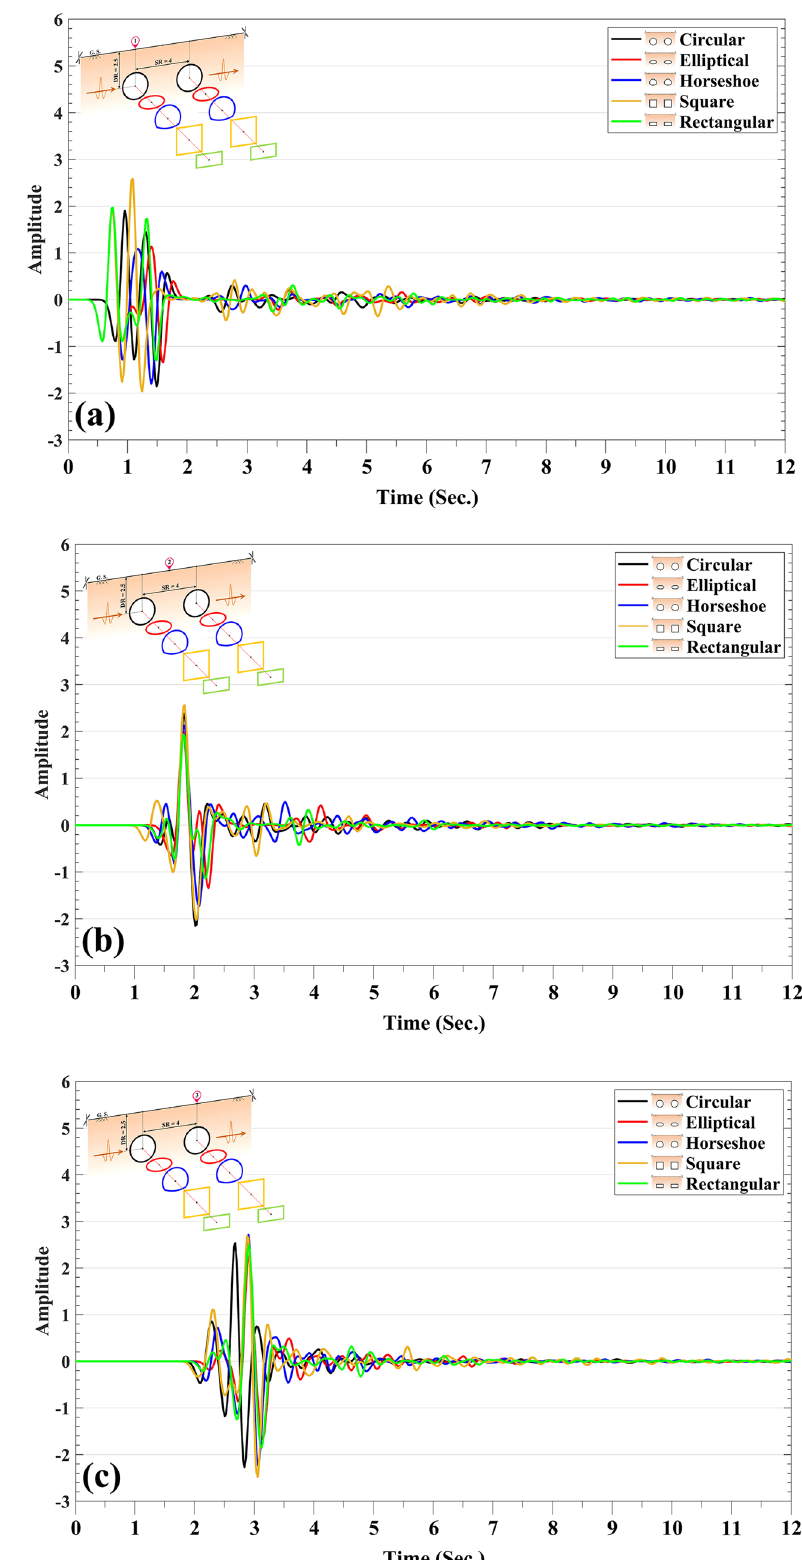
Fig. 4 The amplitude of propa- gated waves on the surface versus time, for the model of twin lined tunnels with differ- ent geometries in a centerline of the first tunnel, b central point, c centerline of the second tunnel subjected to the horizontal incident SH